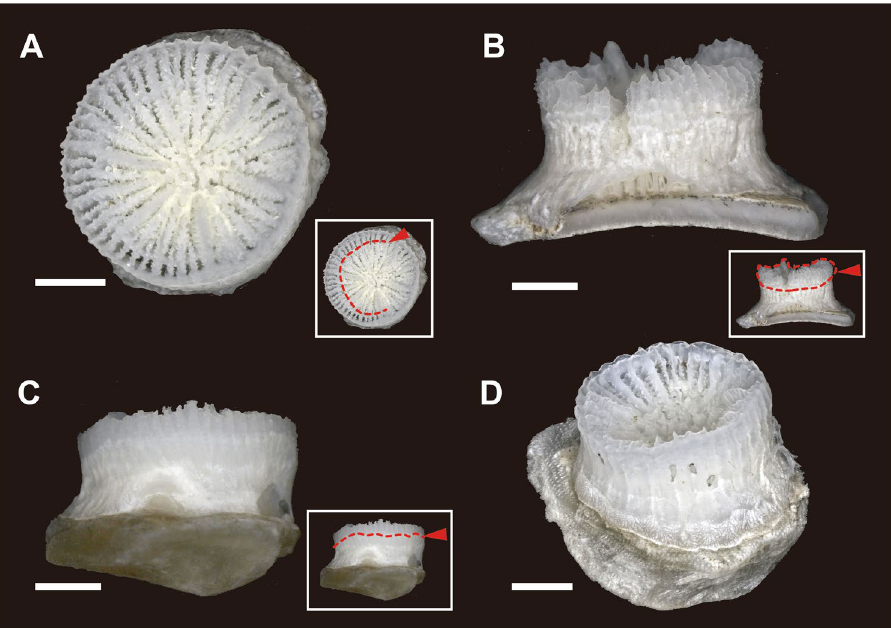
Figure 4. Undescribed species (anthocauli of Deltocyathoides orientalis) with transverse division scar. Red dotted lines and arrows indicate the auxiliary lines of the division scar. ( A ) Circular walls formed inside the calice as in a marked rejuvenescence. ( B ) primary septa protrude above corallite, and upper part of corallite is bulging. ( C ) Decalcification scar developed perpendicular to the growth direction of the corallite. ( D ) The center of the calice is depressed, and the upper part of the septum is curved toward the center. Scale bars = 1